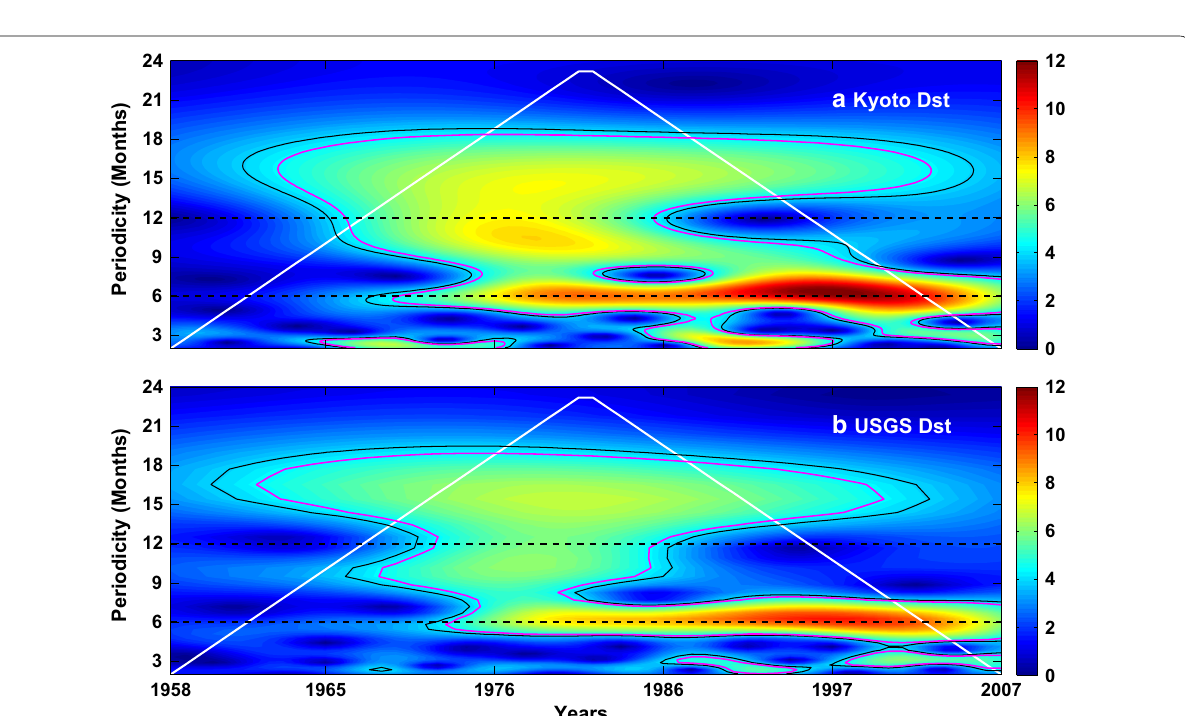
Fig. 7 Wavelet amplitude spectra of the number of storms in solar cycles 19–23 (12 tude in units of number of storms, white lines indicate cone of confidence and black and purple curves represent 95 and 98% significant